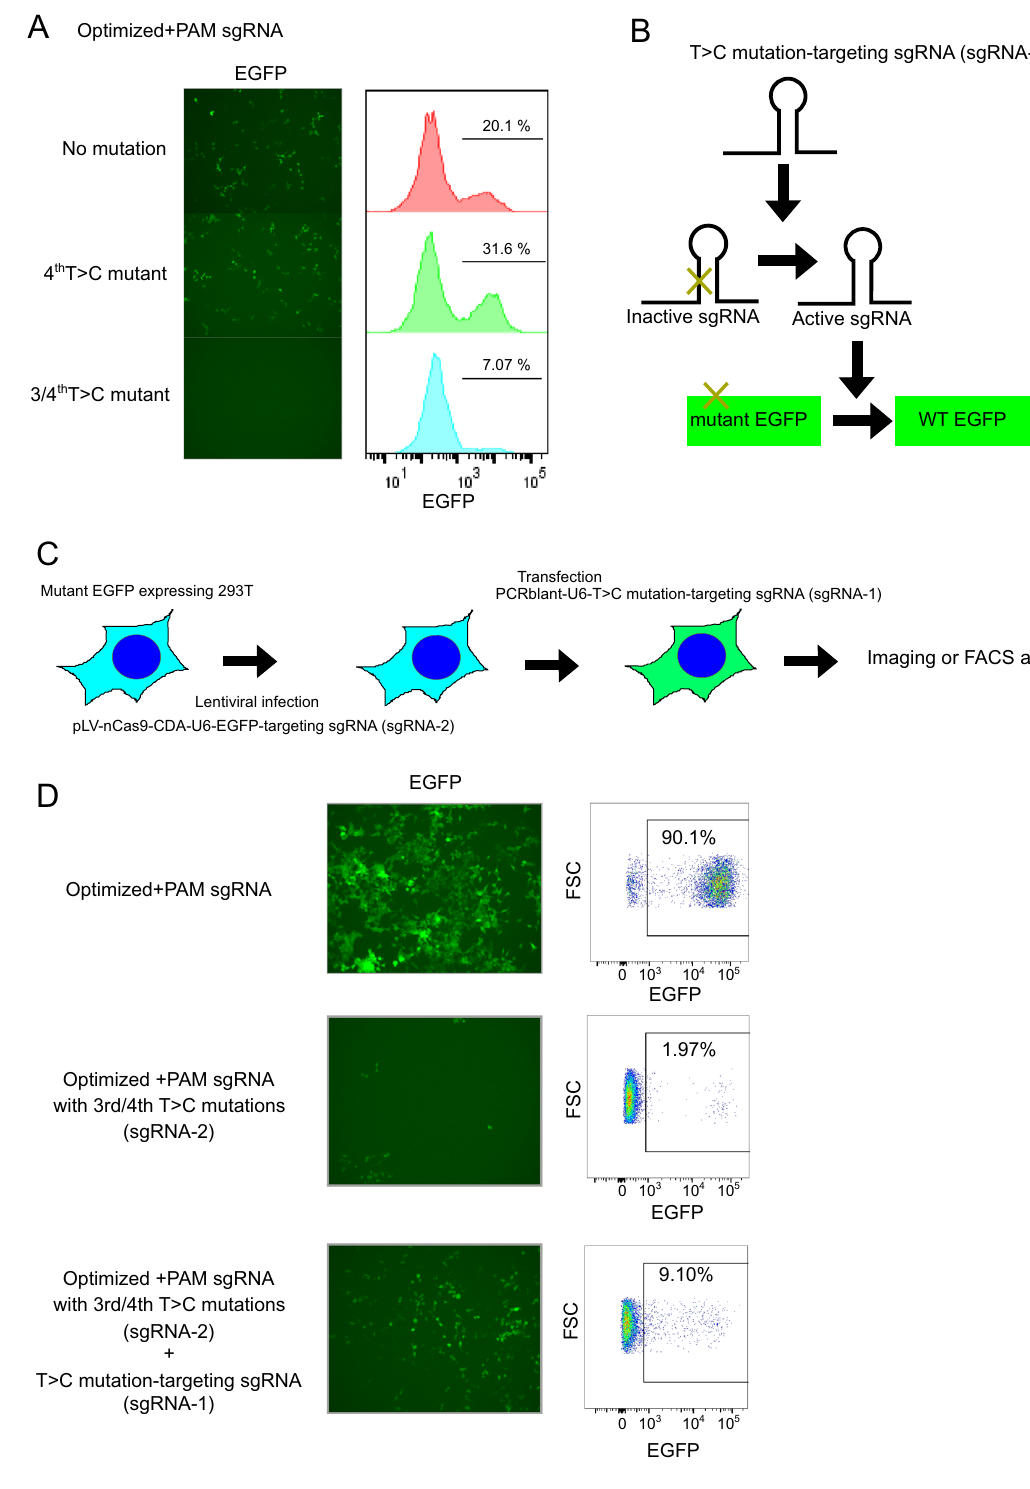
Figure 4. Cellular chain reaction systems through sequential repair of sgRNA scaffold mutations. ( A ) Fluorescence images (left) and FACS plots (right) of 293 T cells expressing mutant EGFP and nCas9-CDA together with different sgRNAs. The indicated T > C mutations were introduced into the optimized PAM- inserted sgRNA. mut; mutation. ( B ) Schematic representation of the chain reaction by repair of sgRNA scaffold mutations to express EGFP in 293 T cells. ( C ) Experimental scheme as in ( D ). 293 T cells were transduced with mutant EGFP, nCas9-CDA and an EGFP-targeting sgRNA, then transfected with another sgRNA targeting the T > C mutation. ( D ) Fluorescence images (left) and FACS plots (right) of 293 T cells expressing mutant EGFP and nCas9-CDA together with the indicated sgRNAs. The sgRNA-1 converted the inactive sgRNA-2 to an active form, and the sgRNA-2 corrected the EGFP mutation to induce EGFP